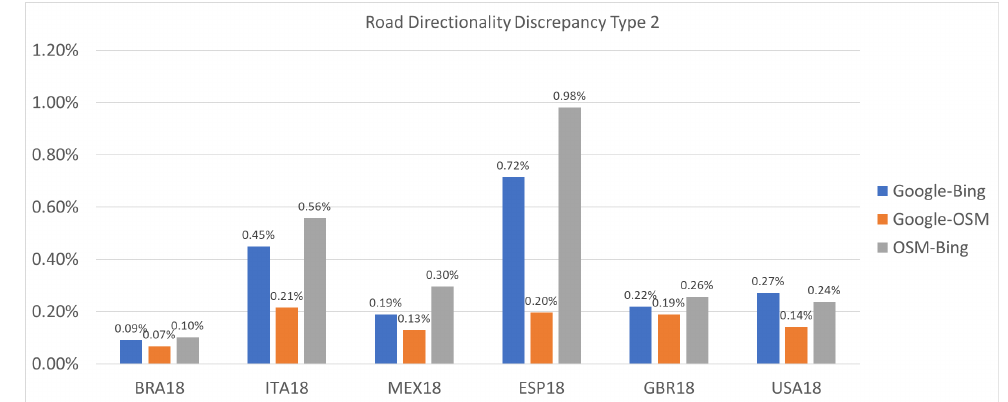
Figure 18. Road direction discrepancy stats Type 2 (strong discrepancy). For example, for Spain, our Google Maps vs. Bing Maps comparison detects strong discrepancies representing a percentage of 0.72%. Figures 19 and 20 present strong discrep- ancies examples found in this region for Google Maps vs. Bing Maps.